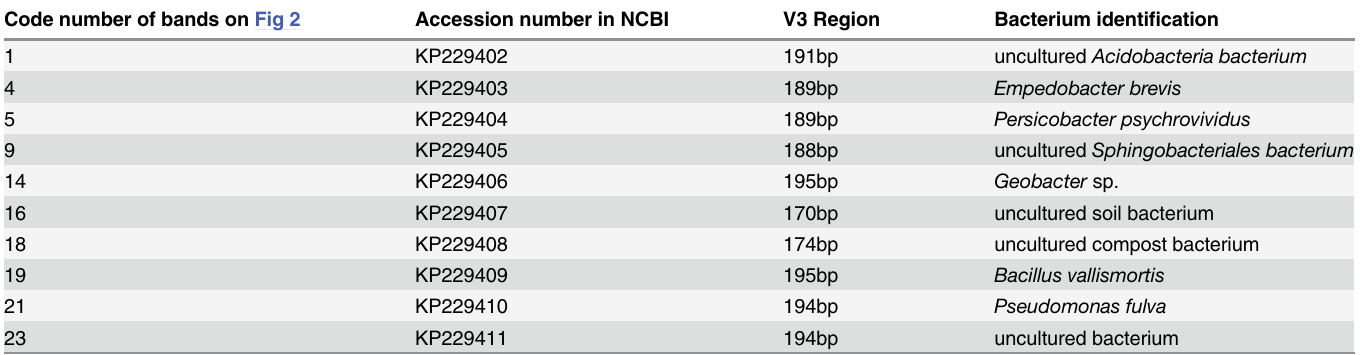
Table 6. Identification of bacteria for ten bands sequenced in the sole-cropping experiment. Code number of bands on Fig